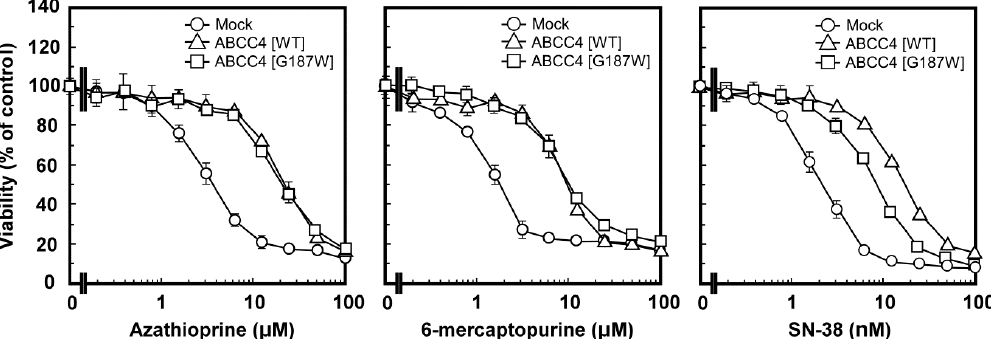
Figure 5. Anticancer drug resistance profiles of cells established using the Flp-In™ system. The anticancer drug resistance profiles of the cells were evaluated using the 3-(4,5-dimethyl-2-thiazol-2-yl)-2,5-diphenyl-2H-tetrazolium bromide (MTT) assay, as described in Materials and Methods. Data are expressed as mean values ± S.D. (n = 3–4).